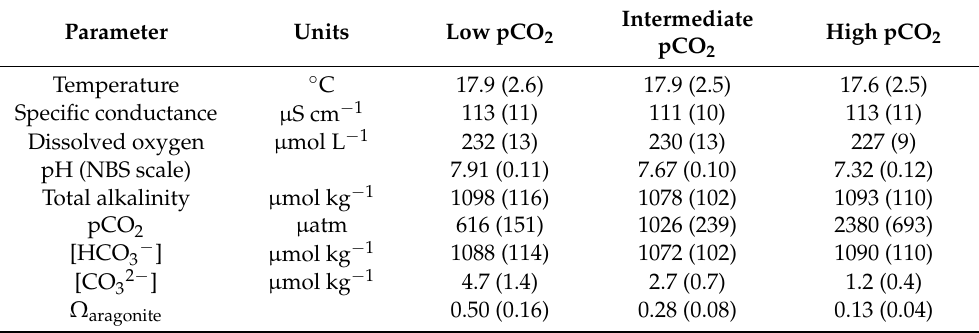
Table 1. Average treatment conditions during the experiment. Measurements are the mean (standard deviation) of 12 tanks per treatment over 35 sampling